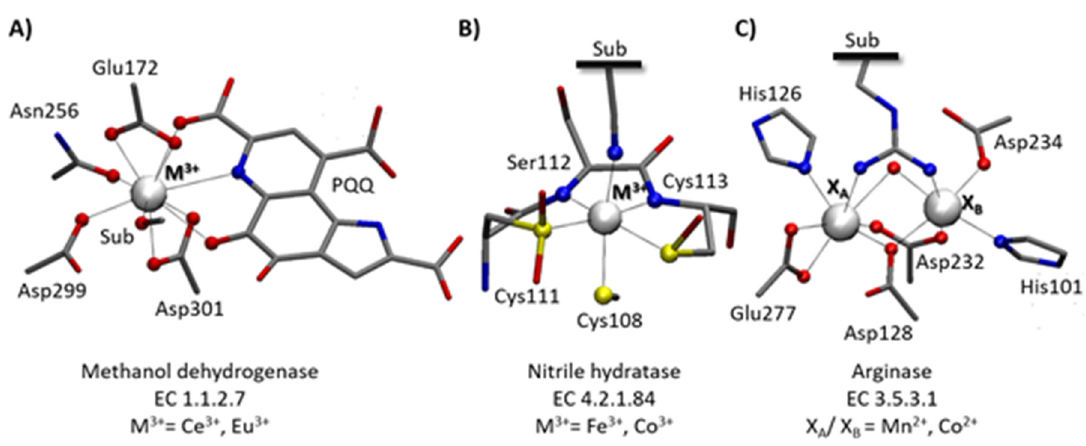
Figure 1. The first coordination shell of ( A ) methanol dehydrogenase, ( B ) nitrile hydratase, and ( C ) arginase, herein discussed.